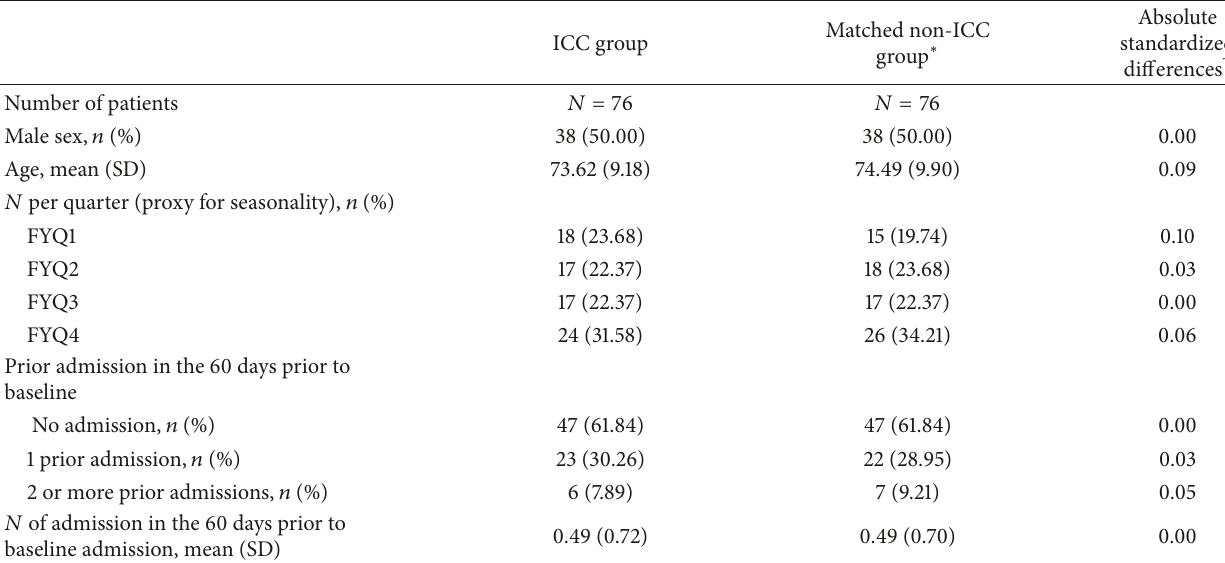
Table 2: Baseline characteristics within the matched